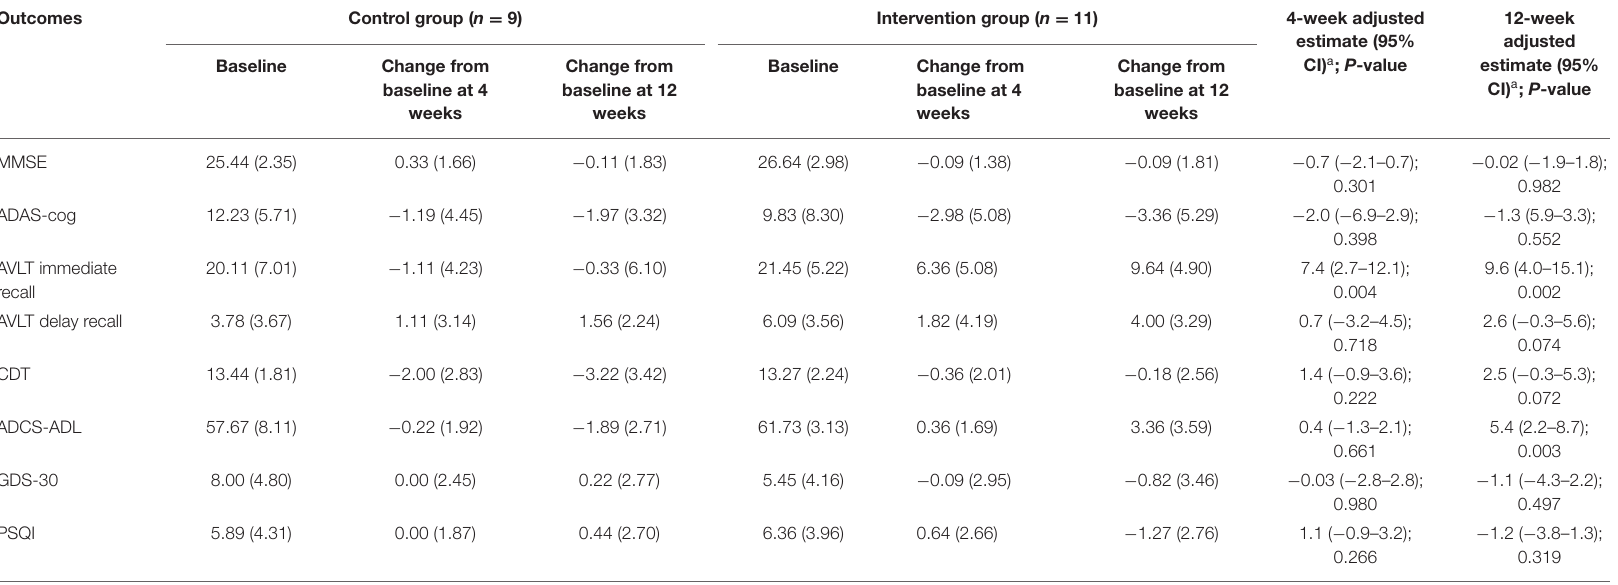
TABLE 2 | Adjusted comparison of neuropsychological outcomes between changes from baseline at 4 and 12 weeks after intervention in patients with MCI ( n = 20). Outcomes Control group ( n = 9) Intervention group ( n = 11) 4-week adjusted